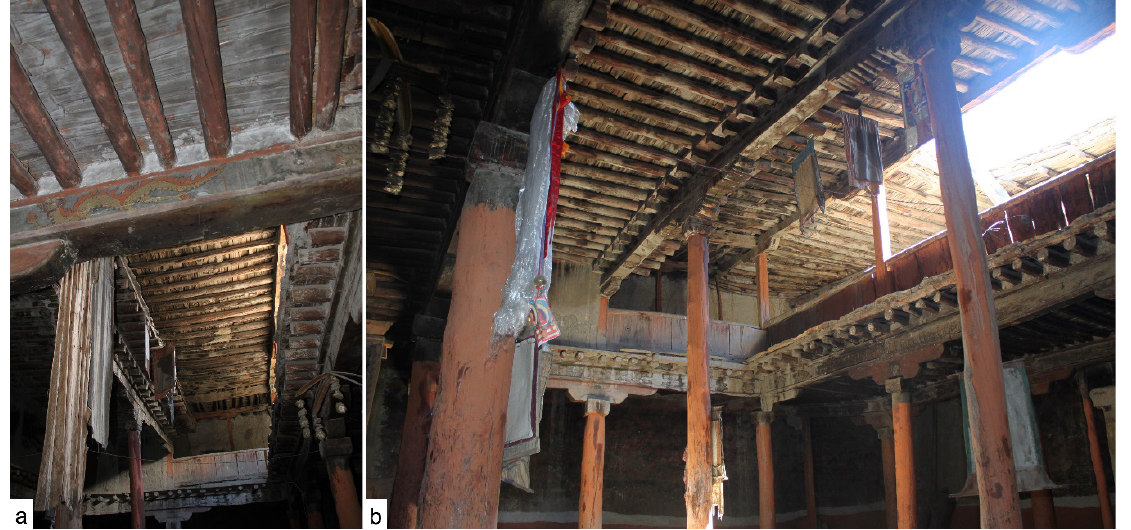
Figure 5. Gönpa Gang ground floor: ( a ); the central bays of the ceiling open to the first floor; ( b ) a one-bay opening in the roof—the source of light for both the dukhang on the ground floor and the gallery above the dukhang.